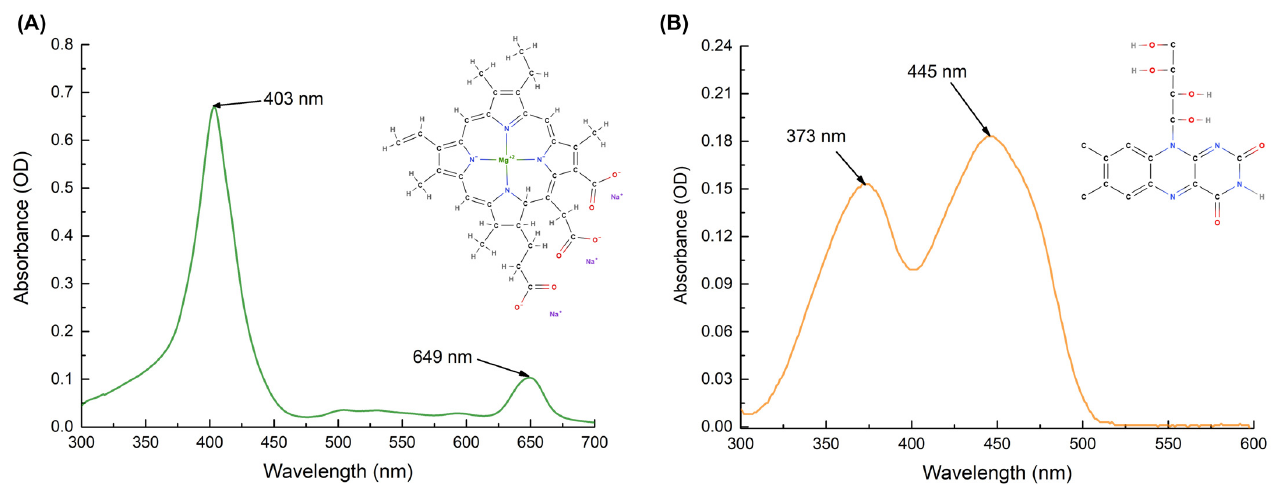
Figure 7. Absorption spectra of 15 µM Chl ( A ) and 11 µM RF ( B ) solutions in distilled water. Chem- ical structures of PSs are